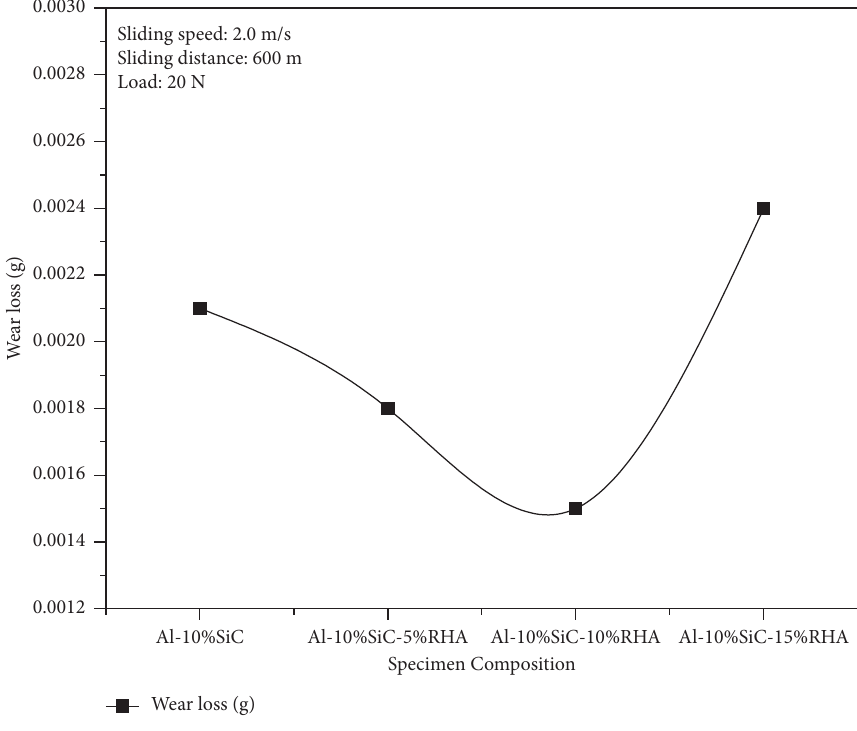
Figure 14: Wear loss of Al/SiC/FA HAMCs with varied FA wt% [89].